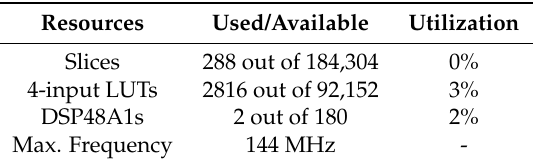
Table 6. FPGA resources